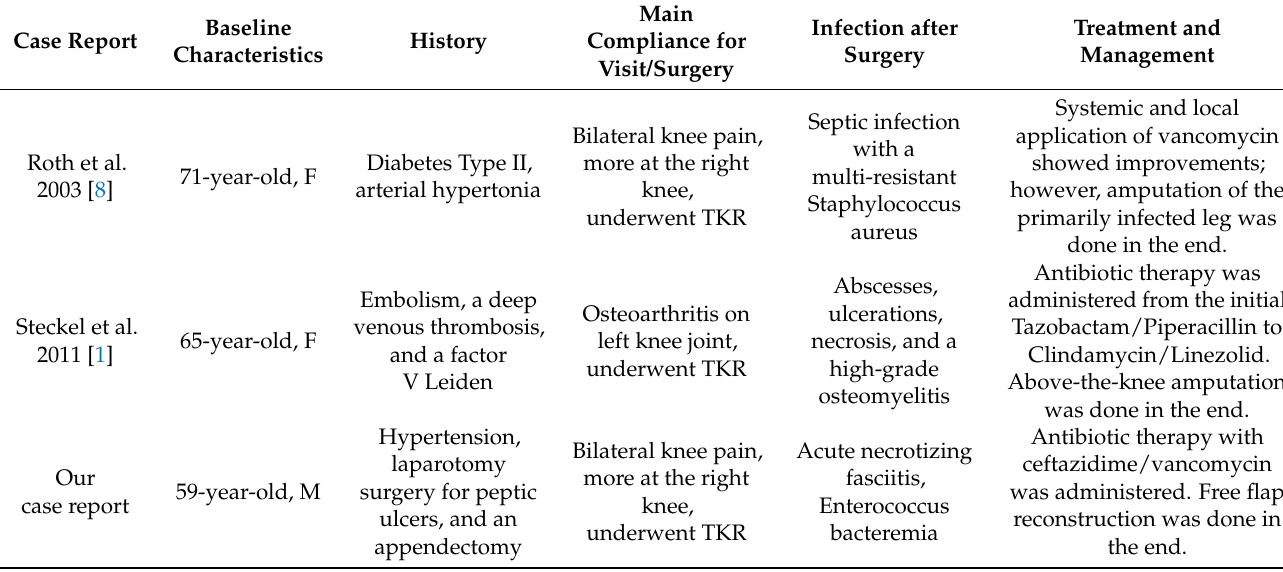
Figure 2. Acute necrotizing fasciitis infection happening one week postoperative. Table 1. Comparison between this case report and two previous similar case